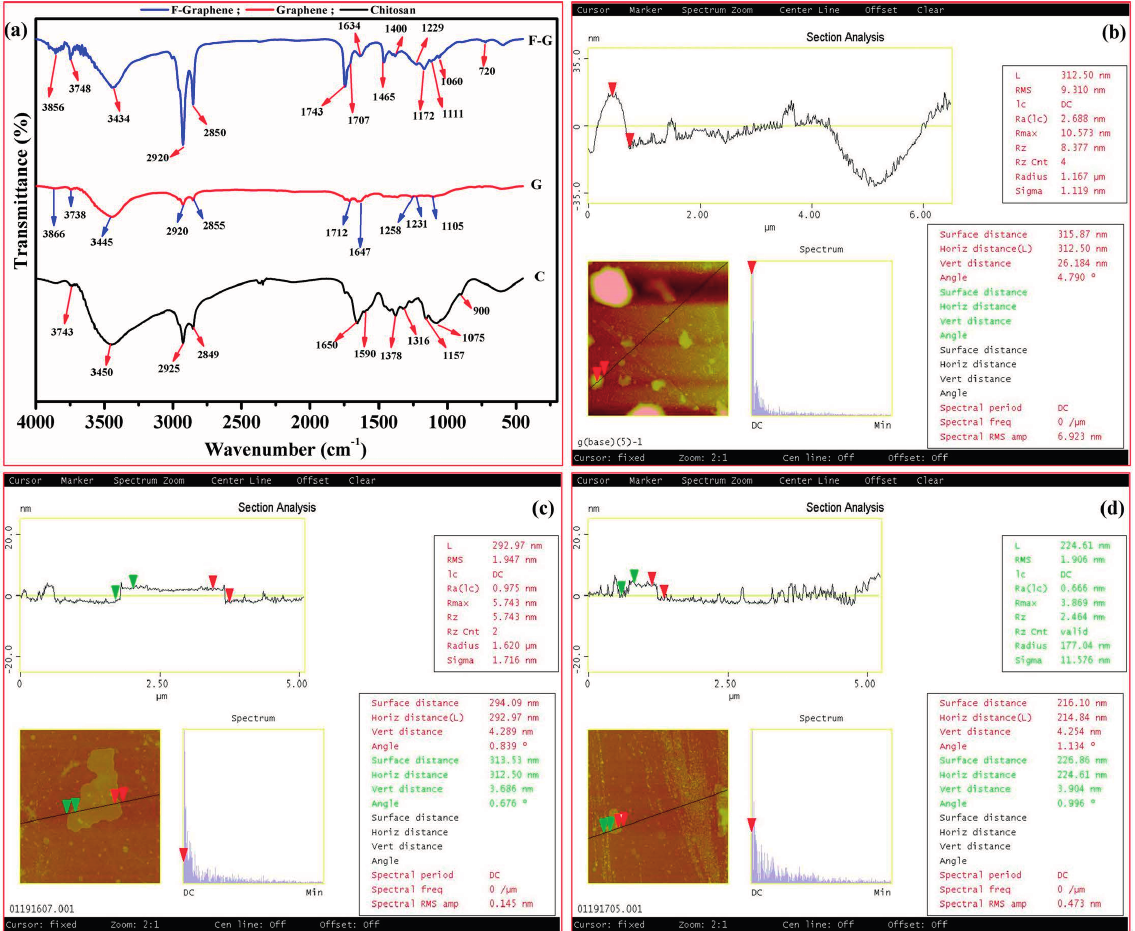
Figure 10. ( a ) FTIR spectrum of chitosan, graphene and functionalized graphene along with their peak data; ( b ) AFM images and sectional analysis of graphene, ( c ) oxidized graphene and ( d ) functionalized